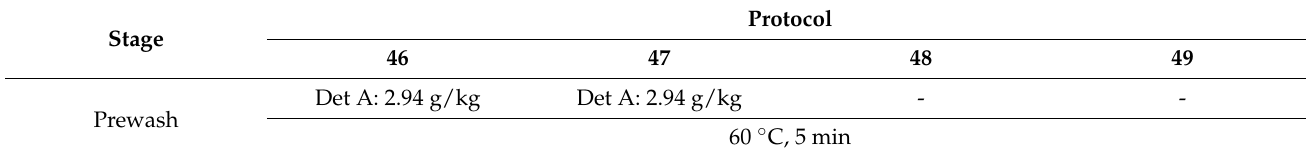
Table 3. Specification of laboratory washing protocols 46, 47, 48 and